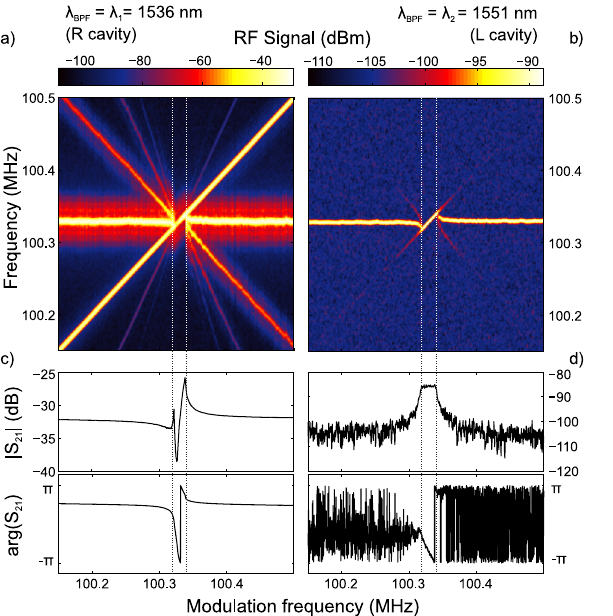
Figure 3: Spectral-domain evidence of injection locking to an external modulation.